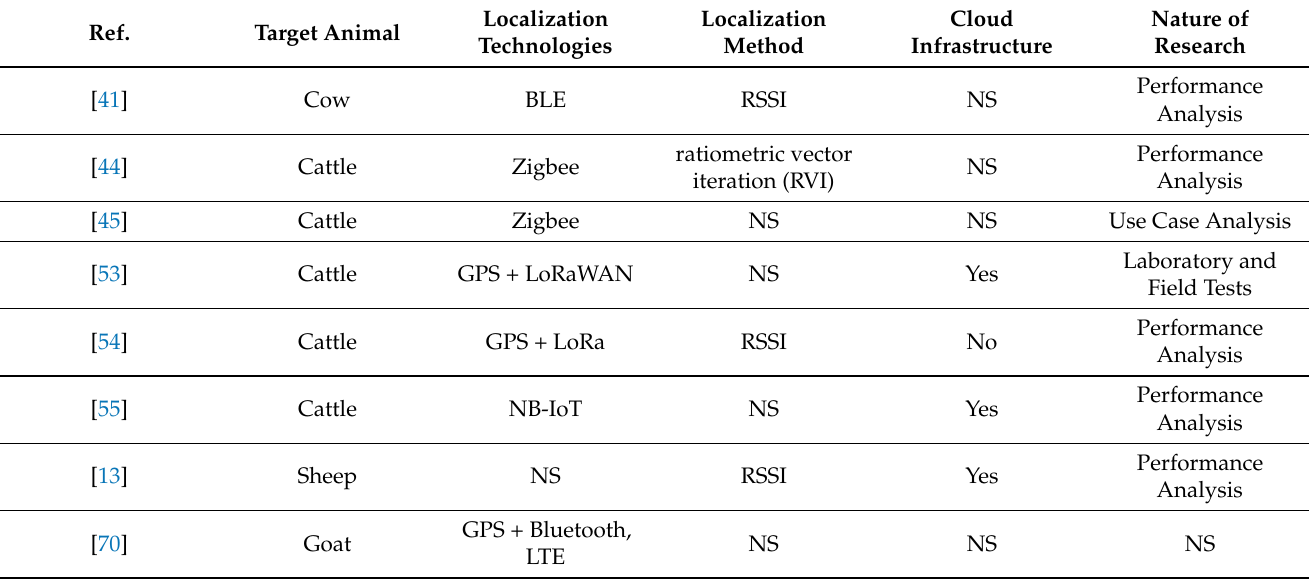
Table 2. A summary of related works.